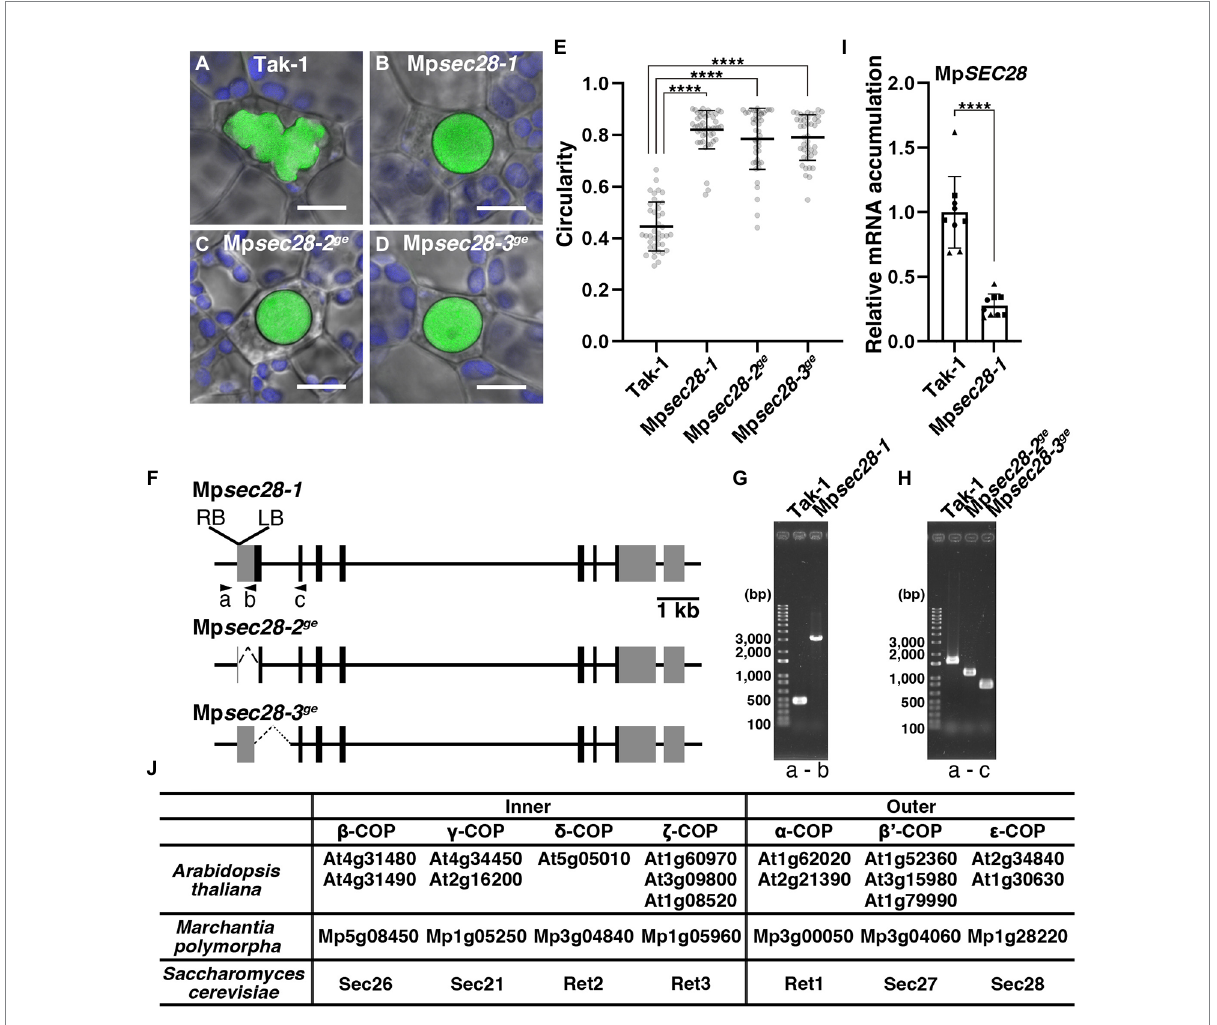
FIGURE 1 Abnormal oil body development in Mp sec28 mutants. (A–D) Confocal images merged with bright-field images of oil bodies in wild-type Tak-1 (A) , Mp sec28-1 (B) , Mp sec28-2 ge (C) , and Mp sec28-3 ge (D) . Green and blue pseudo-colors indicate the fluorescence from BODIPY and chlorophyll, respectively. Bars = 10 μ m. (E) The circularity of the oil bodies in each genotype. Data are presented as the means ± s.d. Differences between wild- type and mutant plants were statistically significant based on a two-tailed Welch’s t -test. **** p < 0.001. The sample numbers were 40, 47, 44, and 42 oil bodies for Tak-1, Mp sec28-1 , Mp sec28-2 ge , and Mp sec28-3 ge , respectively. p = 8.23 × 10 − 32 for Mp sec28-1 , p = 2.73 × 10 − 24 for Mp sec28-2 ge , and p = 4.40 × 10 − 28 for Mp sec28-3 ge . (F) Schematic representation of the Mp SEC28 gene structure and mutations generated in this study. Boxes indicate the UTRs (gray) and coding sequences (black). (G,H) PCR-based genotyping of Tak-1 and Mp sec28-1 (G) , Tak-1, Mp sec28-2 ge , and Mp sec28-3 ge (H) . (F) Shows the primer (A–C) annealing sites. (I) Relative Mp SEC28 mRNA accumulation in Tak-1 and Mp sec28-1 measured by qRT-PCR. Mp APT was used as an internal reference. Data are presented as the means ± s.d. The difference between Tak-1 and Mp sec28-1 was statistically analyzed by a two-tailed Welch’s t -test. **** p < 0.001. Three biological replicates were prepared, and experiments were performed three times for each gene. Each biological replicate is indicated by a circle (replicate 1), triangle (replicate 2), or square (replicate 3). (J) Genes encoding COPI complex subunits in Arabidopsis thaliana , Marchantia polymorpha , and Saccharomyces cerevisiae